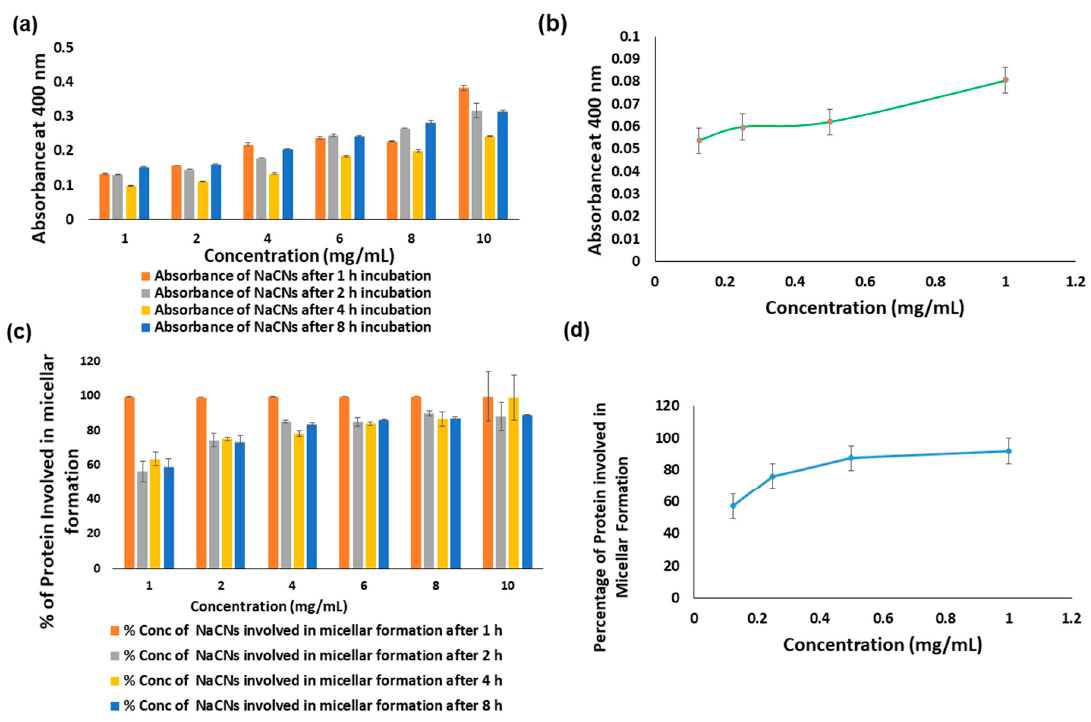
Figure 3. Graphicalanalysisof( a )turbiditymeasurementofNaCNspreparedwithdifferentconcentrations Figure 3. Graphical analysis of ( a ) turbidity measurement of NaCNs prepared with different of sodium caseinate (1, 2, 4, 6, 8 and 10 mg / mL) and at di ff erent mixing times (1, 2, 4 and 8 h); ( b ) turbidity concentrations of sodium caseinate (1, 2, 4, 6, 8 and 10 mg/mL) and at different mixing times (1, 2, 4 measurement of NaCNs prepared with lower concentrations of sodium caseinate (1, 0.5, 0.25 and and 8 h); ( b ) turbidity measurement of NaCNs prepared with lower concentrations of sodium 0.125 mg / mL) and at one hour mixing time; ( c ) estimation of protein contents (using BCA protein kit) in caseinate (1, 0.5, 0.25 and 0.125 mg/mL) and at one hour mixing time; ( c ) estimation of protein contents NaCNs prepared with di ff erent concentrations of sodium caseinate (1, 2, 4, 6, 8 and 10 mg / mL) and at (using BCA protein kit) in NaCNs prepared with different concentrations of sodium caseinate (1, 2, di ff erent mixing times; ( d ) estimation of protein contents in NaCNs prepared with lower concentrations 4, 6, 8 and 10 mg/mL) and at different mixing times; ( d ) estimation of protein contents in NaCNs of sodium caseinate (1, 0.5, 0.25 and 0.125 mg / mL) and at di ff erent mixing prepared with lower concentrations of sodium caseinate (1, 0.5, 0.25 and 0.125 mg/mL) and at different mixing times.